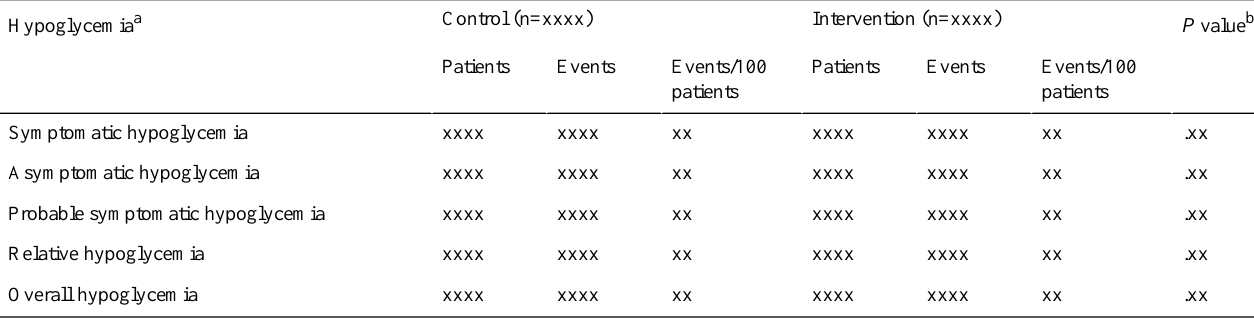
Table 4. Incidence and events rate of hypoglycemia by treatment